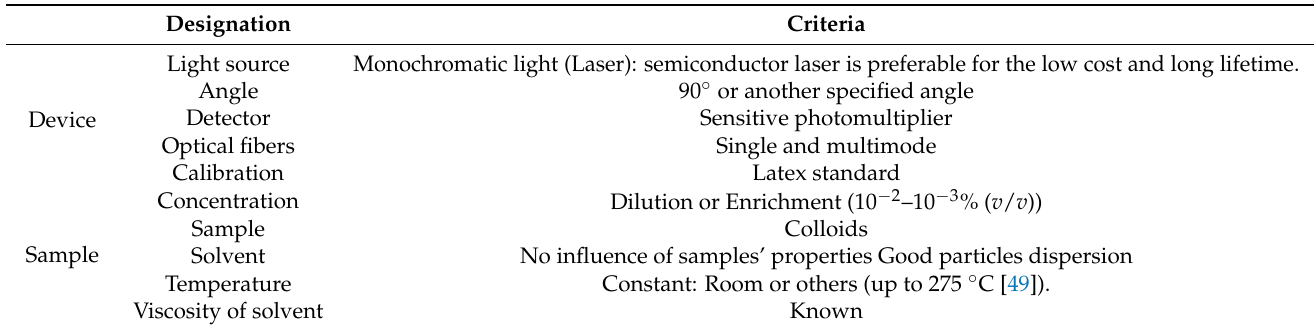
Table 2. Sample preparations and measurement conditions of DLS